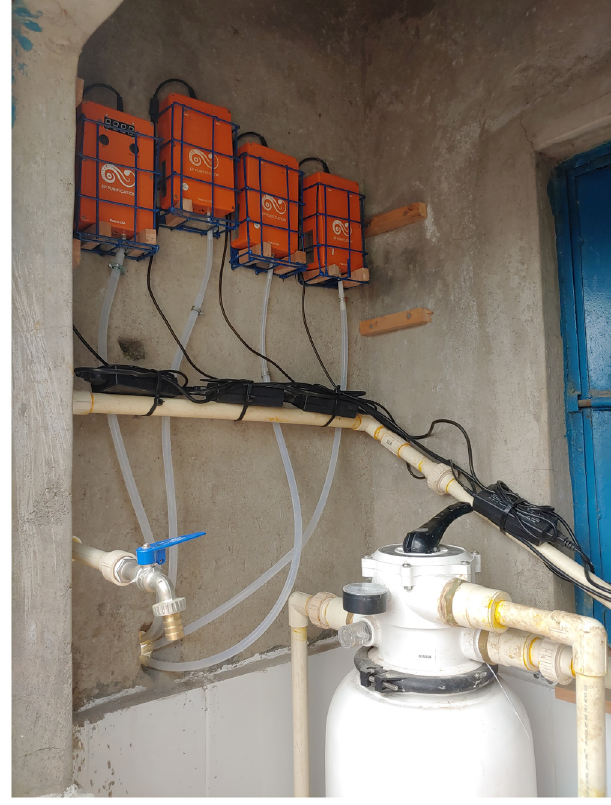
Figure 3. Sales kiosk. Jerrycans of water being prepared by kiosk staff for loading onto a water vendor’s cart. The black tank on the upper right is the settling tank.